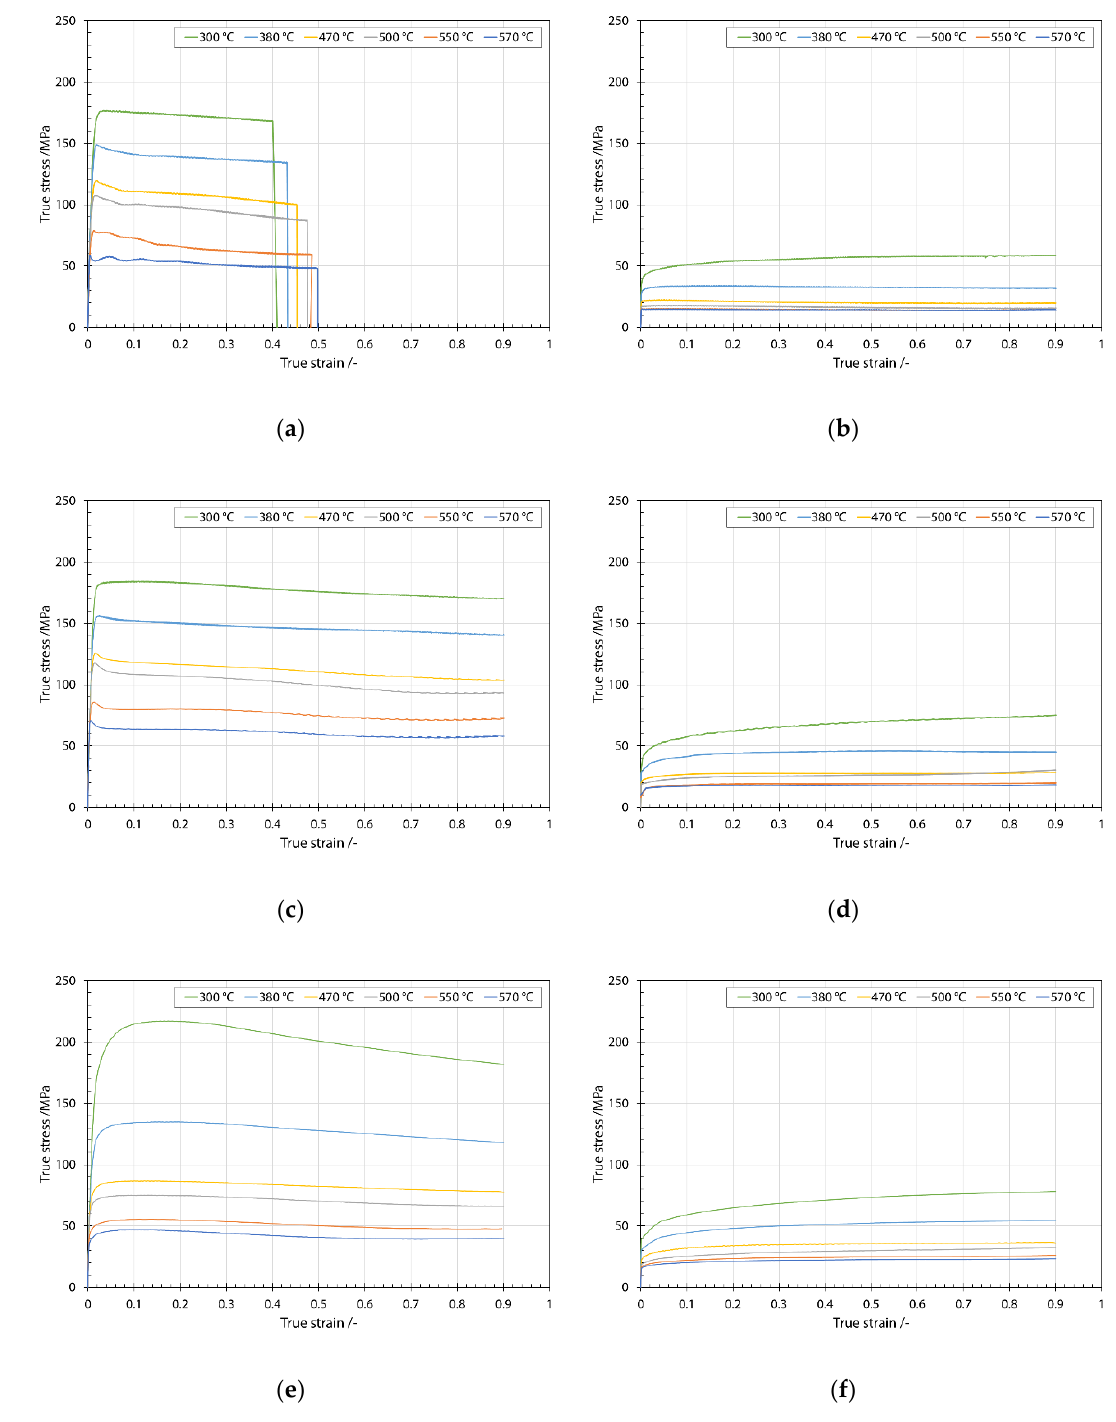
Figure 8. Single-hit hot-compression flow curves at various temperatures: ( a ) directly extruded Al 1080 powder, at a strain rate of 0.1 s −1 ; ( b ) directly extruded conventional AA 1050 alloy, at a strain rate of 0.1 s −1 ; ( c ) directly extruded Al 1080 powder, at a strain rate of 1 s −1 ; ( d ) directly extruded conventional AA 1050 alloy, at a strain rate of 1 s −1 ; ( e ) directly extruded Al 1080 powder, at a strain rate of 5 s −1 ; and ( f ) directly extruded conventional AA 1050 alloy, at a strain rate of 5 s −1 .